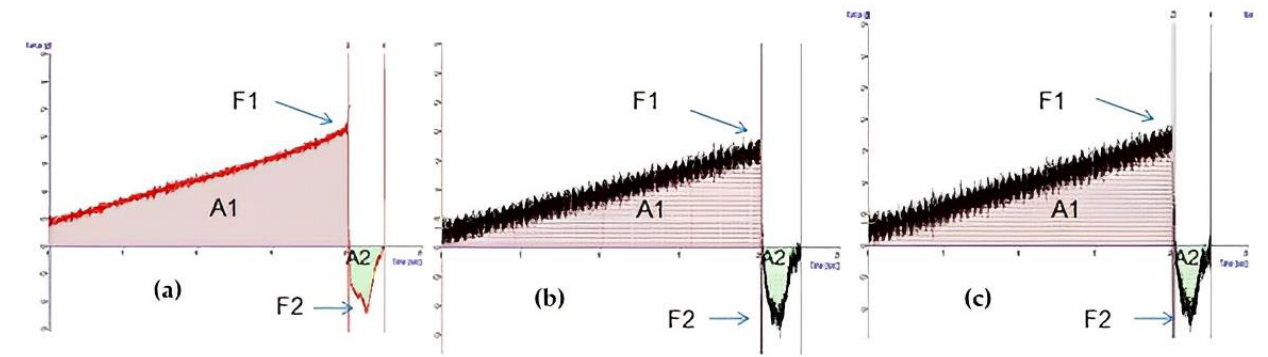
Figure 3 . Texture analysis of hydrogels. A1 (Area 1), A2 (Area 2), F1 (Force 1), F2 (Force 2) of ( a ) chicha hydrogel (GChi), ( b ) chicha hydrogel with 0.01 g mL −1 nerolidol (GChiN1), and ( c ) chicha ( a ) chicha hydrogel (GChi), ( b ) chicha hydrogel with 0.01 g mL − 1 nerolidol (GChiN1), and ( c ) chicha hydrogel with 0.02 g mL −1 nerolidol (GChiN2). hydrogel with 0.02 g mL − 1 nerolidol